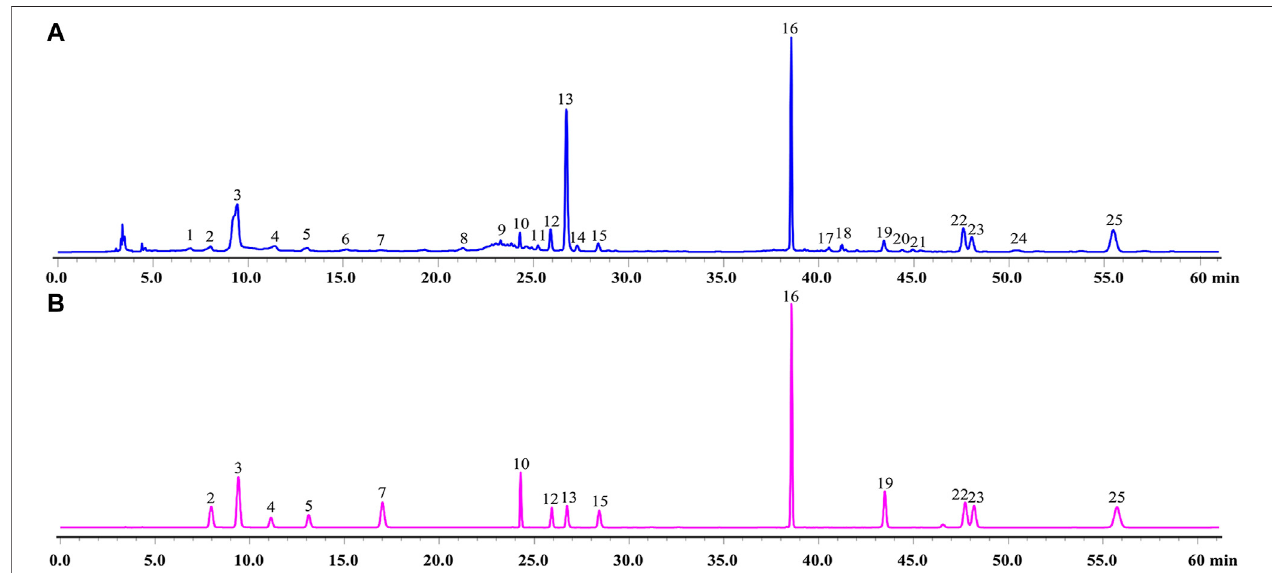
FIGURE 2 | HPLC chromatograms of GXSTC (A) and mixed standard sample (B) at 274 nm. Mixed standard sample was consisted of gallic acid (2), 5- Hydroxymethylfurfural(3),danshensu(4),protocatechuicacid(5),protocatechualdehyde(7),ellagicacid(10),rosmarinicacid(12),salvianolicacidB(13),salvianolicacid A (15), eugenol (16), dihydrotanshinone I (19), cryptotanshinone (22), tanshinone I (23), tanshinone IIA